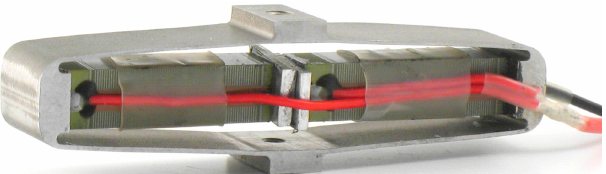
Figure 10. CEDRAT APA400M amplified piezoelectric stack (courtesy of Cedrat Technologies